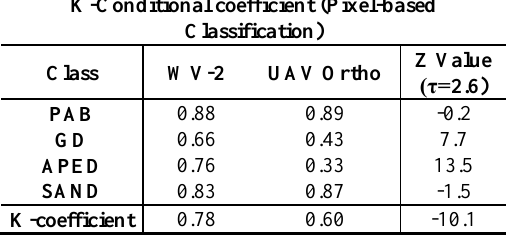
Table 3. Pixel: K-Conditional coefficients and Z-test results data, but discreetly classified in the WV-2 data. Only the PAB and SAND classes can be considered as equally classified by the two